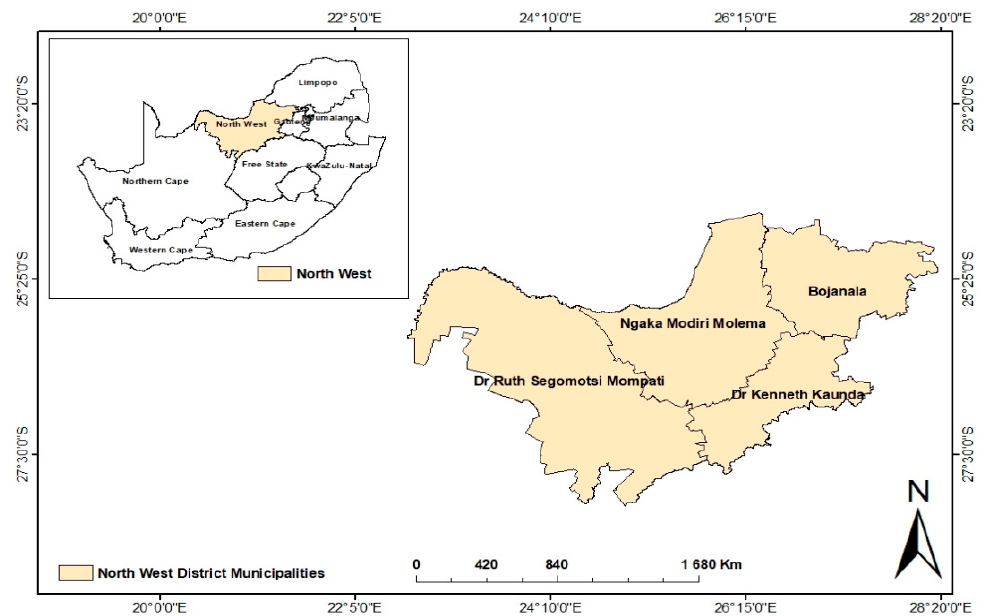
Figure 1. Study sites were located across the four district municipalities of the North West Province, South Africa. Table 1. Study sites (villages and townships) in the four districts in North West Province, South Africa. No of Administered No of Properly Filled District Municipality Community Questionnaires Questionnaires